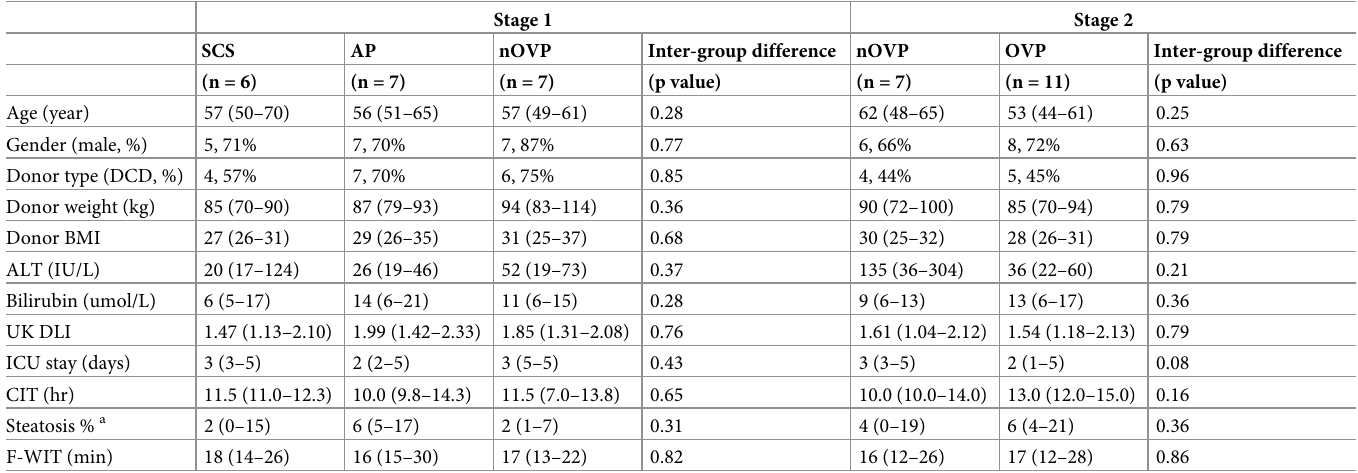
Table 2. Comparison of donor liver characteristics between preservation